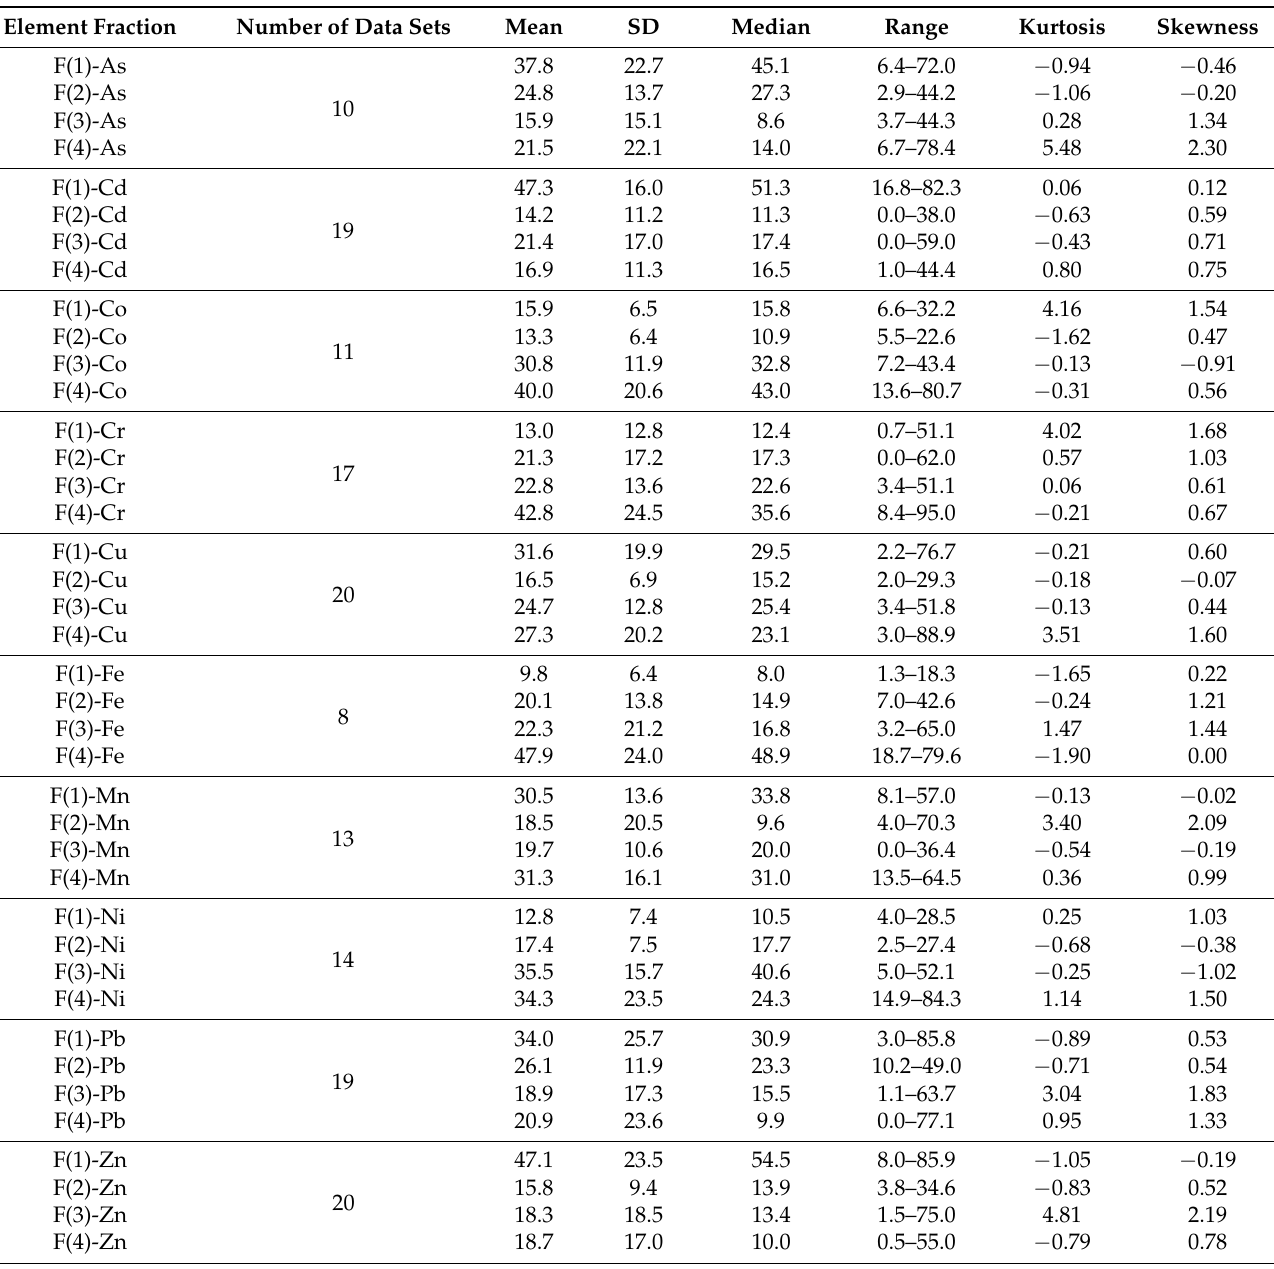
Table 3. Descriptive statistics of literature data of operational speciation of As, Cd, Co, Cr, Cu, Fe, Mn, Ni, Pb and Zn occurring in urban air particulate matter by BCR procedure. The element fraction content is given as a percentage of its total content